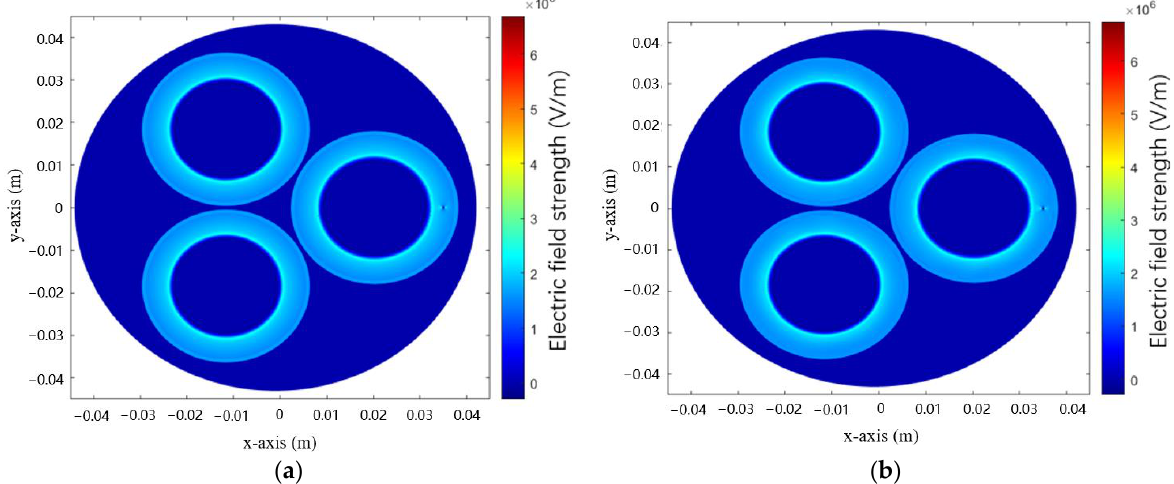
Figure 4. Comparison of calculated values of the data-driven model with finite element method for changing impurity conductivity, ( a ) Electric field strength calculated by the data-driven model, ( b ) Electric field strength calculated by finite element.